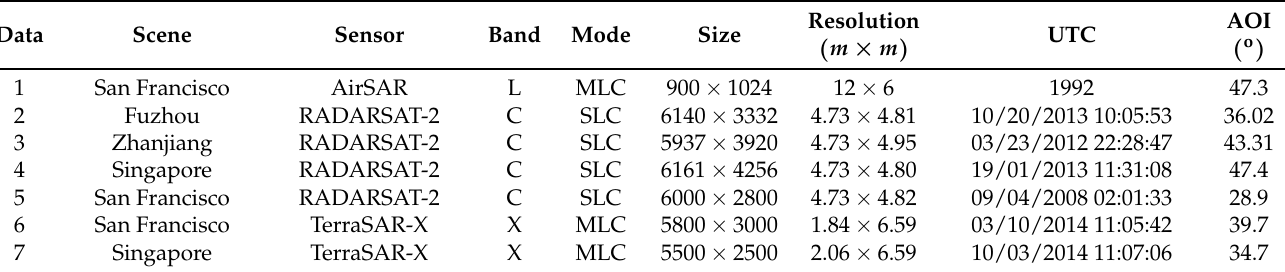
Table 1. Details of the experimental data, where UTC stands for the international standard time, AOI stands for the angle of incident, m × m stands for meter times meter, MLC stands for multi-look complex data, and SLC stands for single-look complex